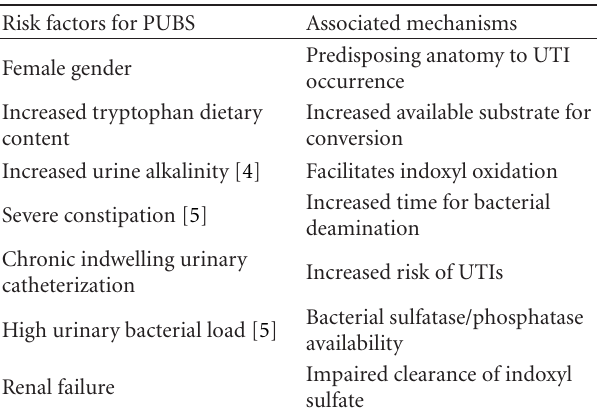
Table 1: Risk factors and associated mechanisms in PUBS.